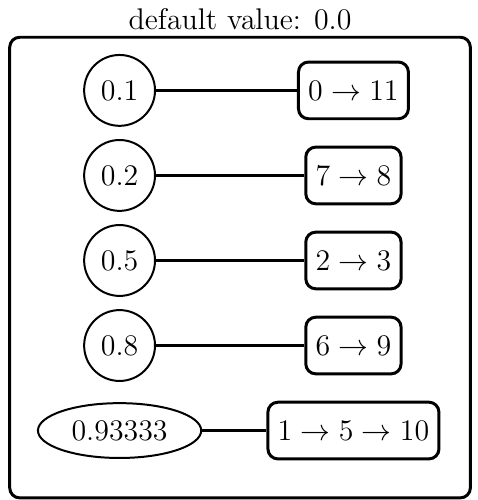
Figure 11. Approximation of φ obtained in the first iteration. In the second iteration, there are only 4 candidate structures to consider, as shown in Table